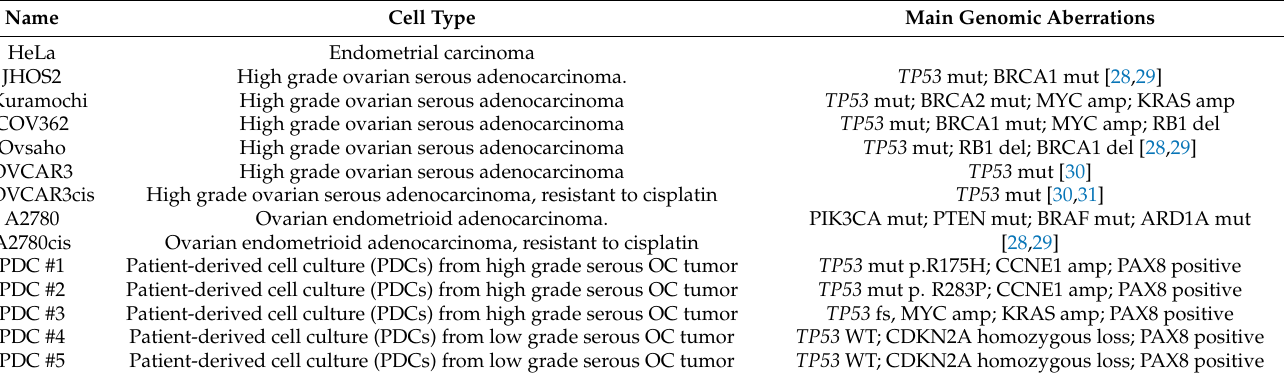
Table 1. Summary of cell lines and patient-derived cell lines used in these studies. Abbreviations: mut: mutation, amp: amplification, fs: frameshift, del: